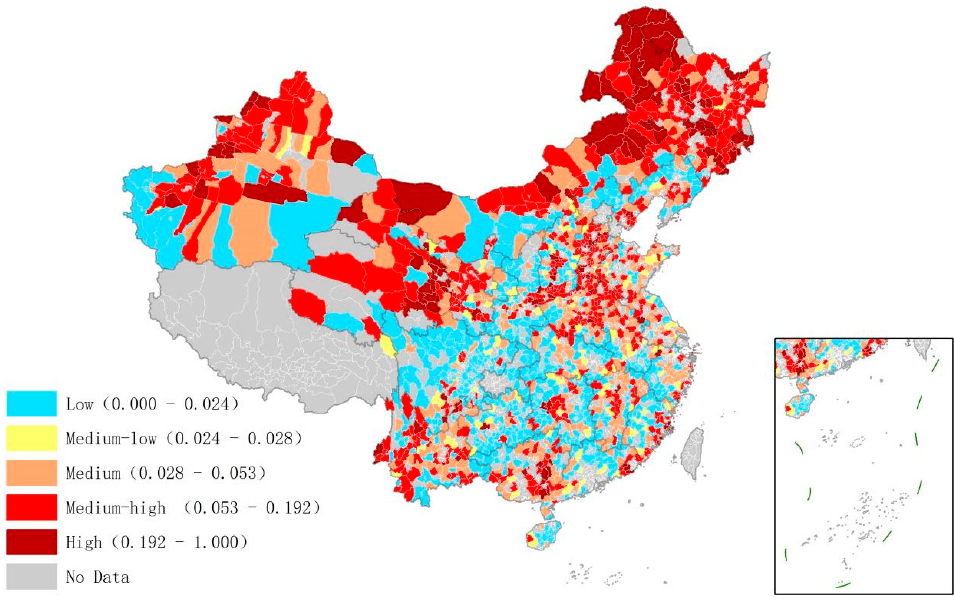
Figure 3. Low-carbon management efficiency of the transportation sector in Chinese counties.